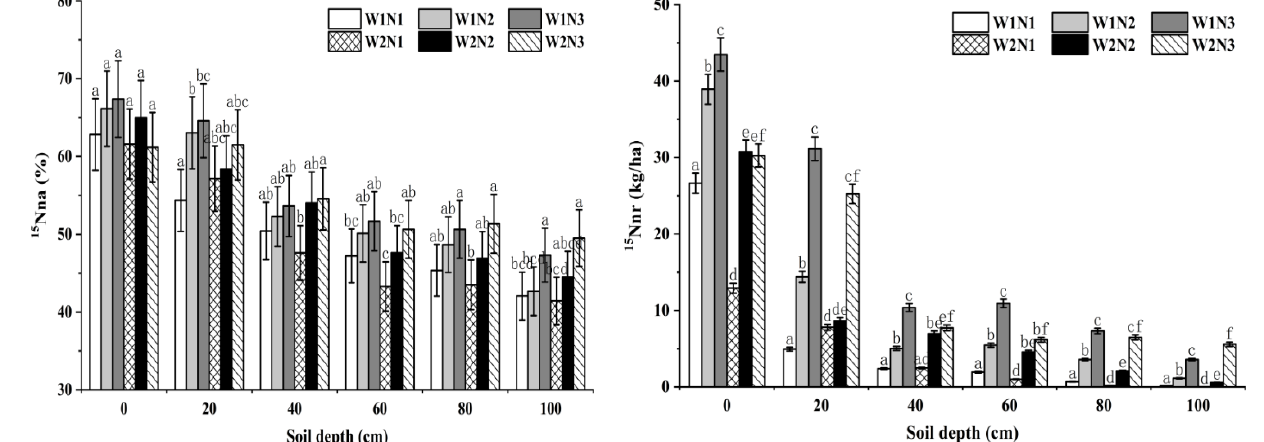
Figure 4. Distribution of 15 Nna ( left ) and 15 N residues ( right ) in the soil. Note: different letters indicate significant differences between different treatments (at p < 0.05 (Tukey’s post hoc test). W1N1:0.75 ETc, 191.4 kg/ha, W1N2:0.75 ETc, 254.4 kg/ha, W1N3:0.75 ETc, 317.4 kg/ha; W2N1:1.0